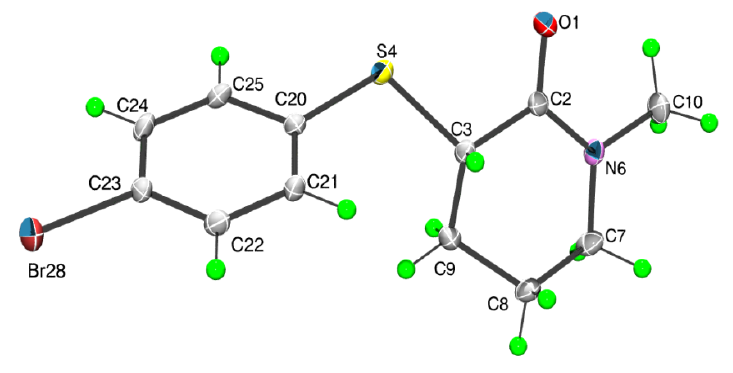
Figure 3. The molecular structure of 2 showing atom labelling scheme and displacement ellipsoids at the 50% probability level (arbitrary spheres for the H-atoms).